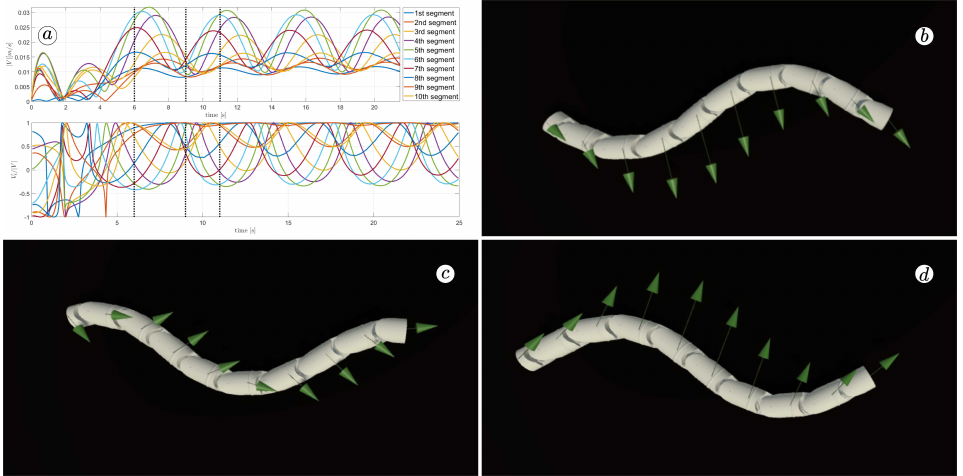
Figure 18. Absolute value and tangential component of segments velocities for c t = 1 and c n = 10 ( a ) and velocity vectors for t = 6 ( s ) ( b ), t = 9 ( s ) ( c ), and t = 11 ( s ) ( d ).